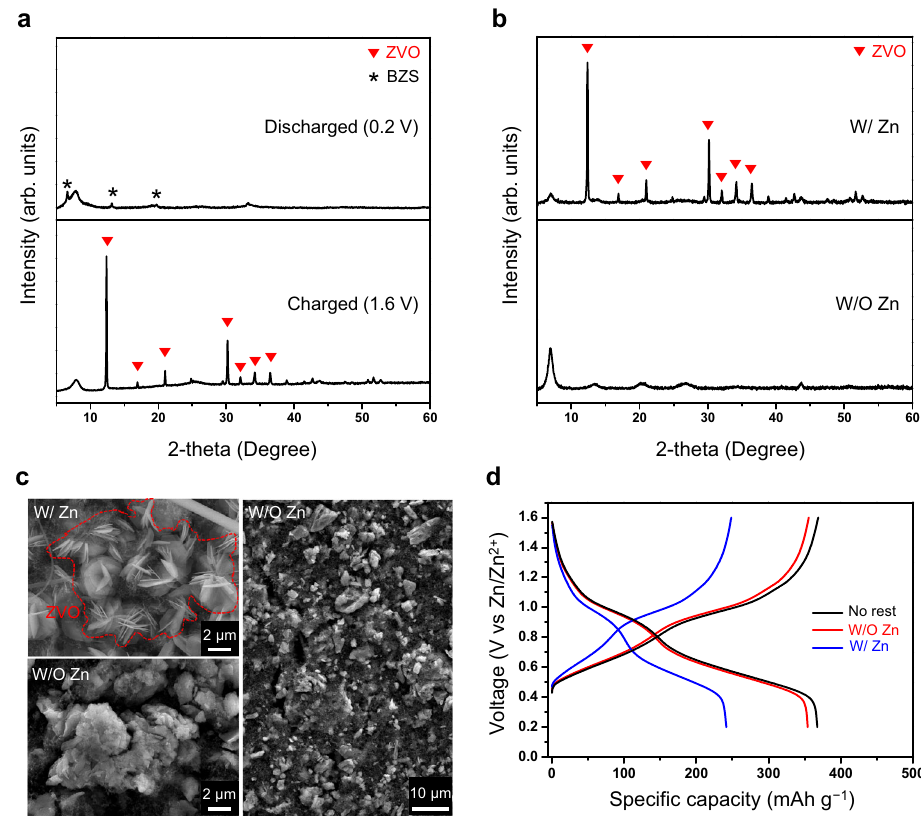
Fig. 3 Dissolution test under various conditions. a Ex-situ XRD patterns of VOX electrodes after reaching different charge/discharge states followed by 5 days of rest. b Ex-situ XRD patterns of VOX electrodes after 5 days of rest at charged state with and without zinc metal counter electrode. c SEM images of VOX electrodes after 5 days of rest at charged state with and without zinc metal counter electrode. d The fi rst galvanostatic charge and discharge pro fi les of VOX electrodes under different test